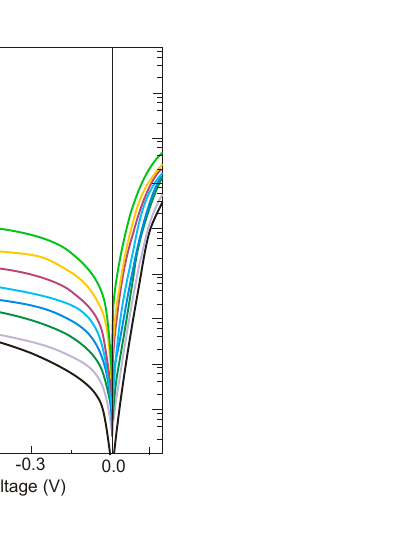
( b ) Figure 60. Spectral characteristics of LWIR T2SLs InAs/InAsSb photodiode: ( a ) QE spectrum with different applied bias at 77 K. Inset: 50% λ cut-off versus temperature; ( b ) the calculated shot noise and Johnson noise limited D* at 77K for different applied bias (after [164]). The effective passivation of T2SLs InAs/InAsSb photodiodes is in a very early stage of development. Usually, photodiodes are not passivated. The simplest passivation is based on the common dielectric insulators deposited onto exposed surface of the device, utilized in the silicon industry (such as an oxide or nitride of silicon). In the case of T2SLs InAs/InAsSb photodiodes, the passivation challenges are caused by the well-known surface accumulation of InAsSb. Sulphur anodic was found to be more effective passivant for p + B p nn + detector structure compared to fluoride and chloride anodic films [186]. In [187] the dark current suppression was observed in 8- μ m λ cut-off T2SLs InAs/InAsSb structure with combination of a double-electron barrier and SiO 2 passivation. In addition, the effect of hydrogenation could be taken into account for passivation of bulk defects in MWIR T2SLs InAs/InAsSb [188]. 6.2.2. Barrier Detectors Klipstein et al. [189] proposed the division of the barrier detectors into two groups: XB n n and XB p p, where X is a contact layer where doping, material, or both can be varied. Usually, however, the most popular are four types of SLs barrier detectors schematically described in Table 5.